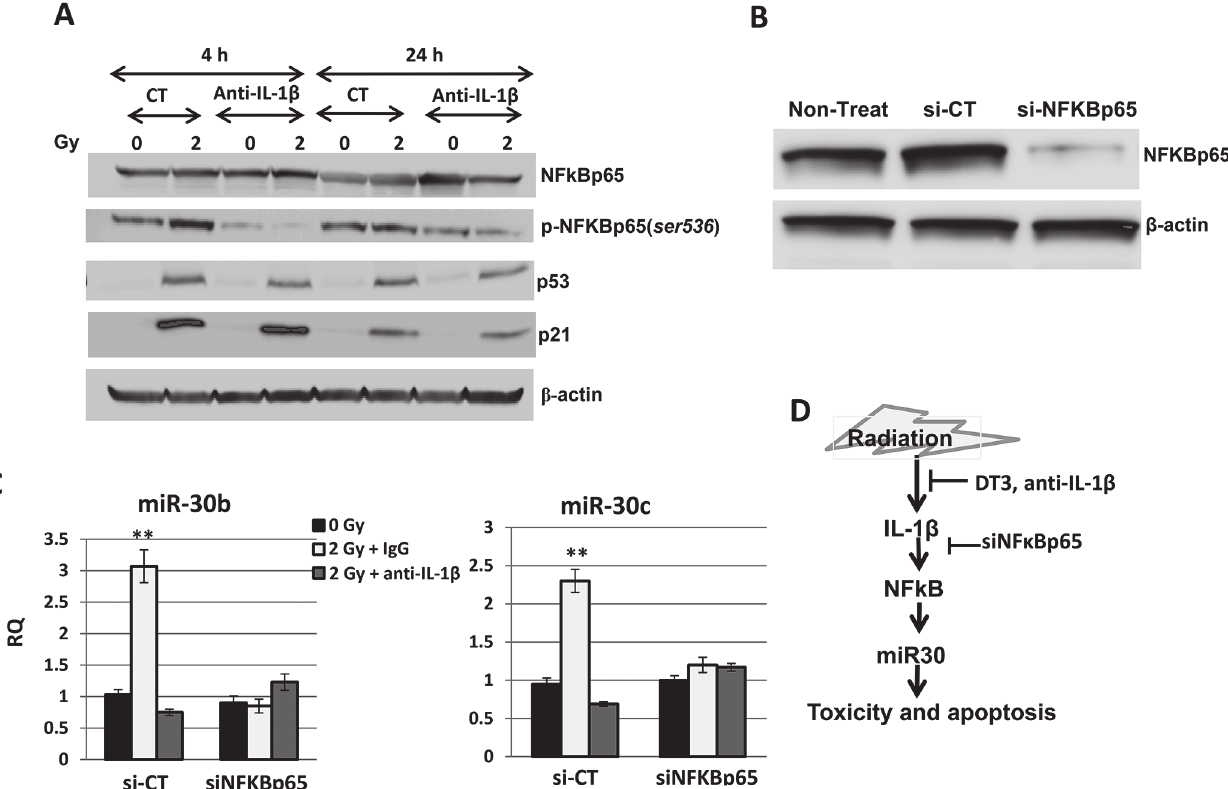
Fig 7. NF κ B activation was responsible to radiation (and IL-1 β )-induced miR-30 expression in CD34+ cells. (A) CD34+ cells treated with control or anti-IL-1 β antibody were collected at 4 h and 24 h after 0 or 2 Gy irradiation. p53, p21, NF κ B expression and phosphorylation of NF κ B (ser536) were examined by immunoblotting assay with β -actin serving as an internal control. Addition of anti-IL-1 β antibody before radiation resulted in a significant inhibition of NF κ B phosphorylation in these cells at 4 h and 24 h post-irradiation. (B) Western blots show NF κ Bp65 and β -actin (loading control) expression in non-transfected, control-siRNA-transfected, and NF κ Bp65-siRNA-transfected samples. (C) MiR-30b and miR-30c expression were validated in sham (0 Gy) or 2 Gy irradiated with or without anti-IL-1 β antibody-treated and siNF κ Bp65 or control-siRNA transfected cells by quantitative real-time RT-PCR. RQ = relative quantitation; results from three independent experiments, ** p < 0.01; mean ± SD. 0 Gy vs. 2 Gy. (D) Schematic diagram of the role of DT3 or anti-IL-1 β antibody in radioprotection. DT3 or anti-IL-1 β antibody inhibited radiation-induced IL-1 β production and reversed IL-1 β -induced NF κ B/miR-30 stress